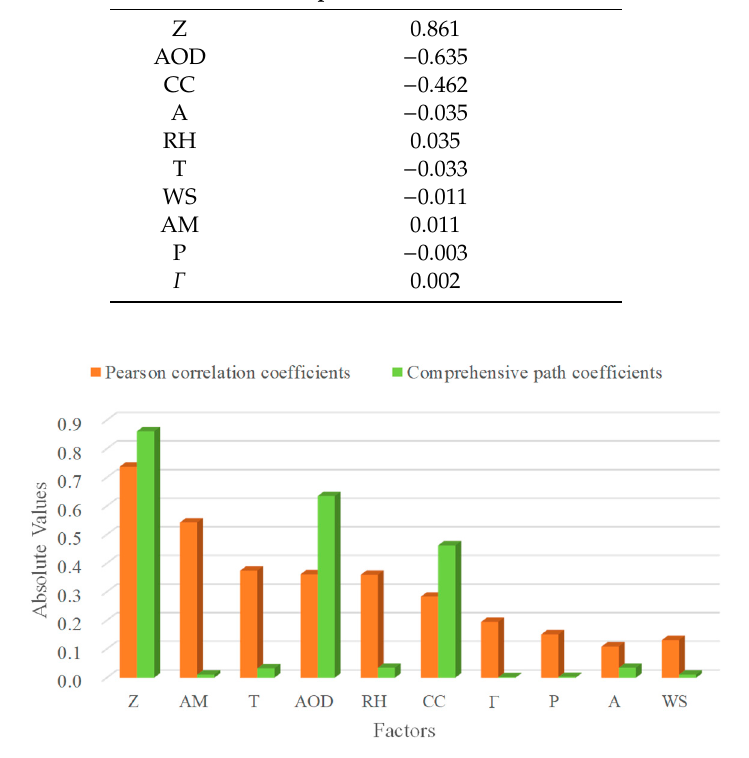
ffi cients of 10 factors to